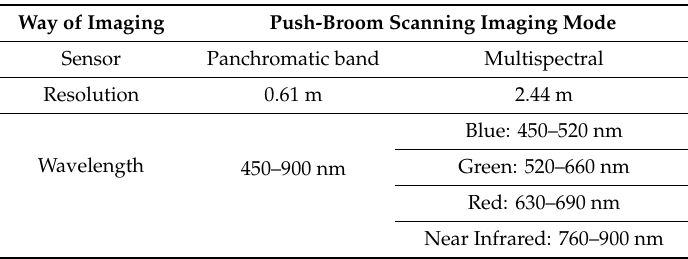
Table 2. Image parameters of QuickBird.